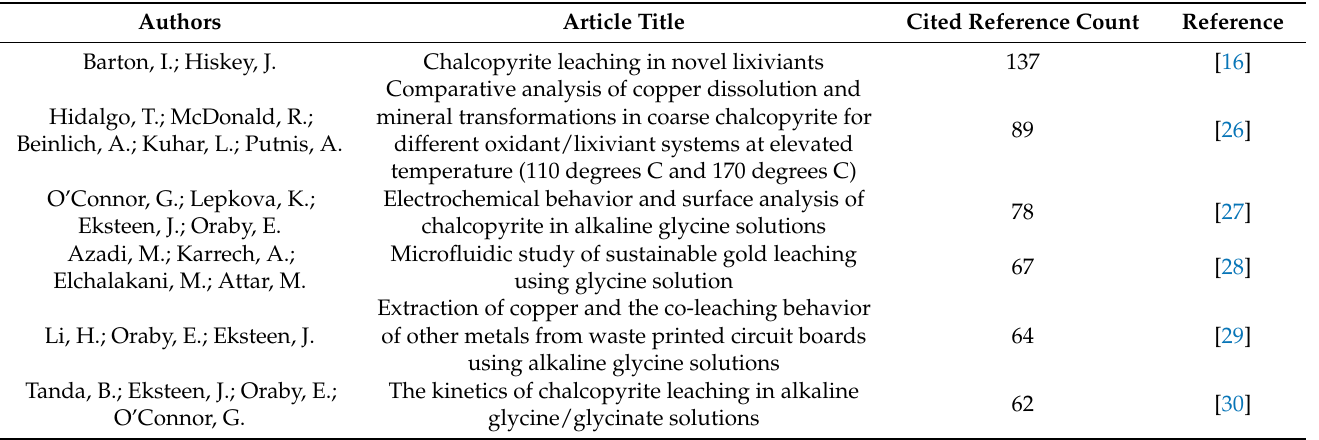
Table 4. Articles most cited (data from 2018 to 2022).